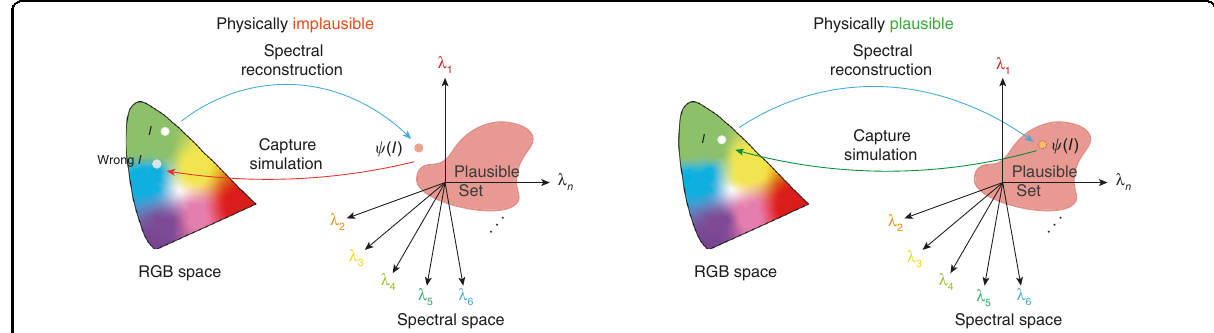
Fig. 8 Illustration of the physically implausible and plausible set. Physically implausible set (left) is the spectra points that cannot be mapped to the original RGB point by the RGB- fi lter response, while physically plausible set (right) is those spectra points that can be mapped back